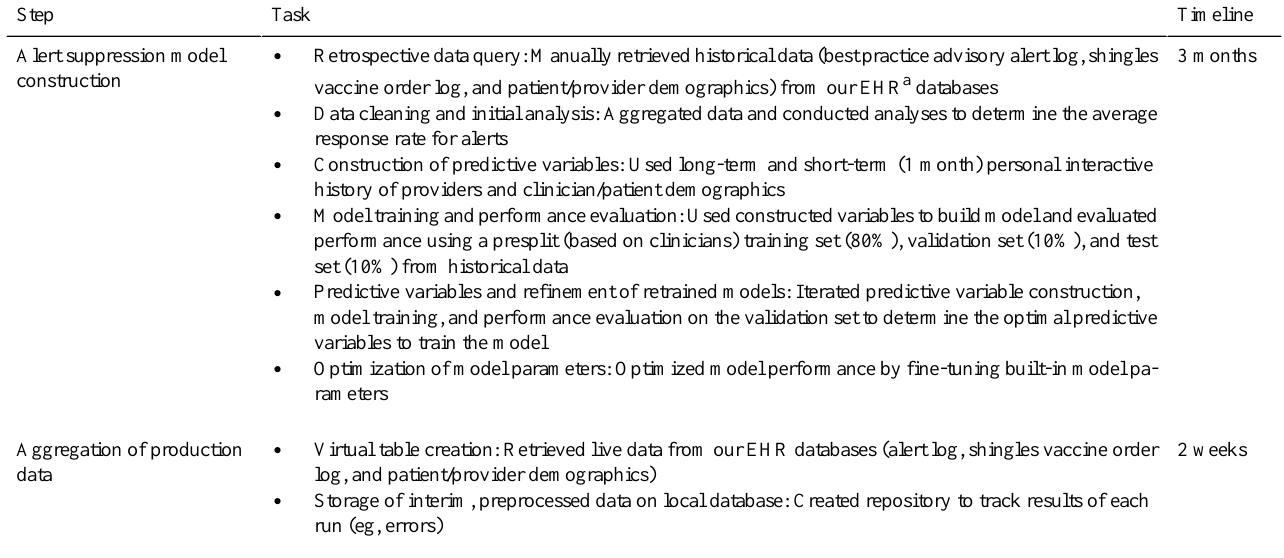
Virtual table creation: Retrieved live data from our EHR databases (alert log, shingles vaccine